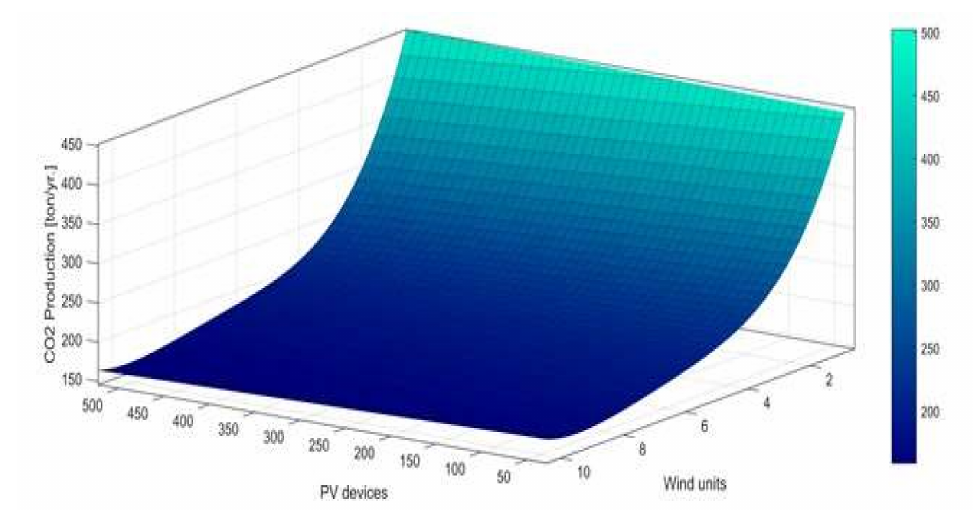
Figure 13. Polynomial regression for CO 2 emission (Rancho